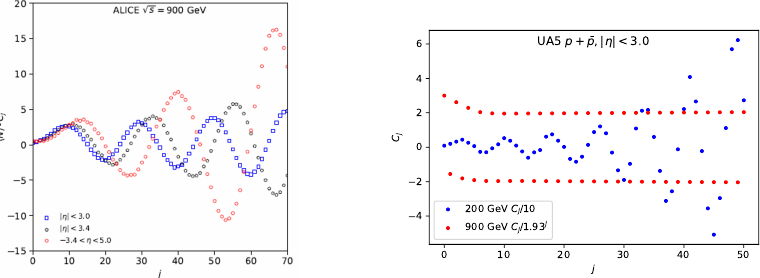
Figure 1: Oscillations in Modified Combinants of hadronic multiplicity distributions with